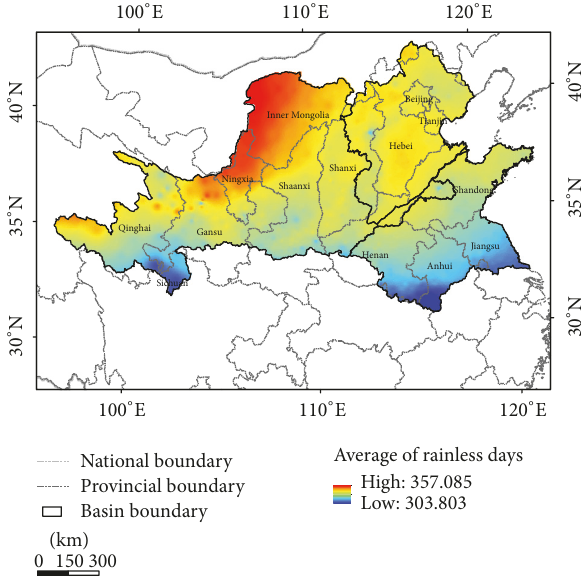
Figure 20: The spatial distribution of multiyear average precipita- tion from 1982 to 2011.